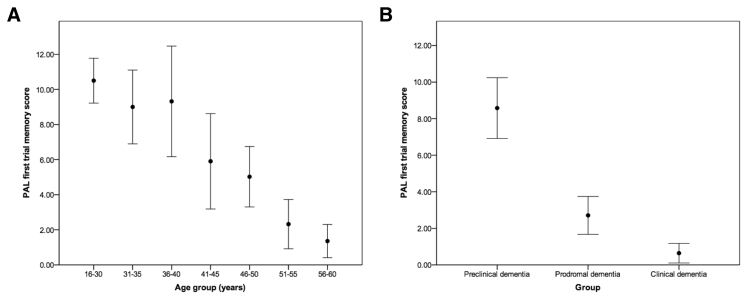
Mean PAL first trial memory scores for (A) different age groups and (B) preclinical, prodromal, and clinical dementia groups (error bars represent 95% confidence intervals).